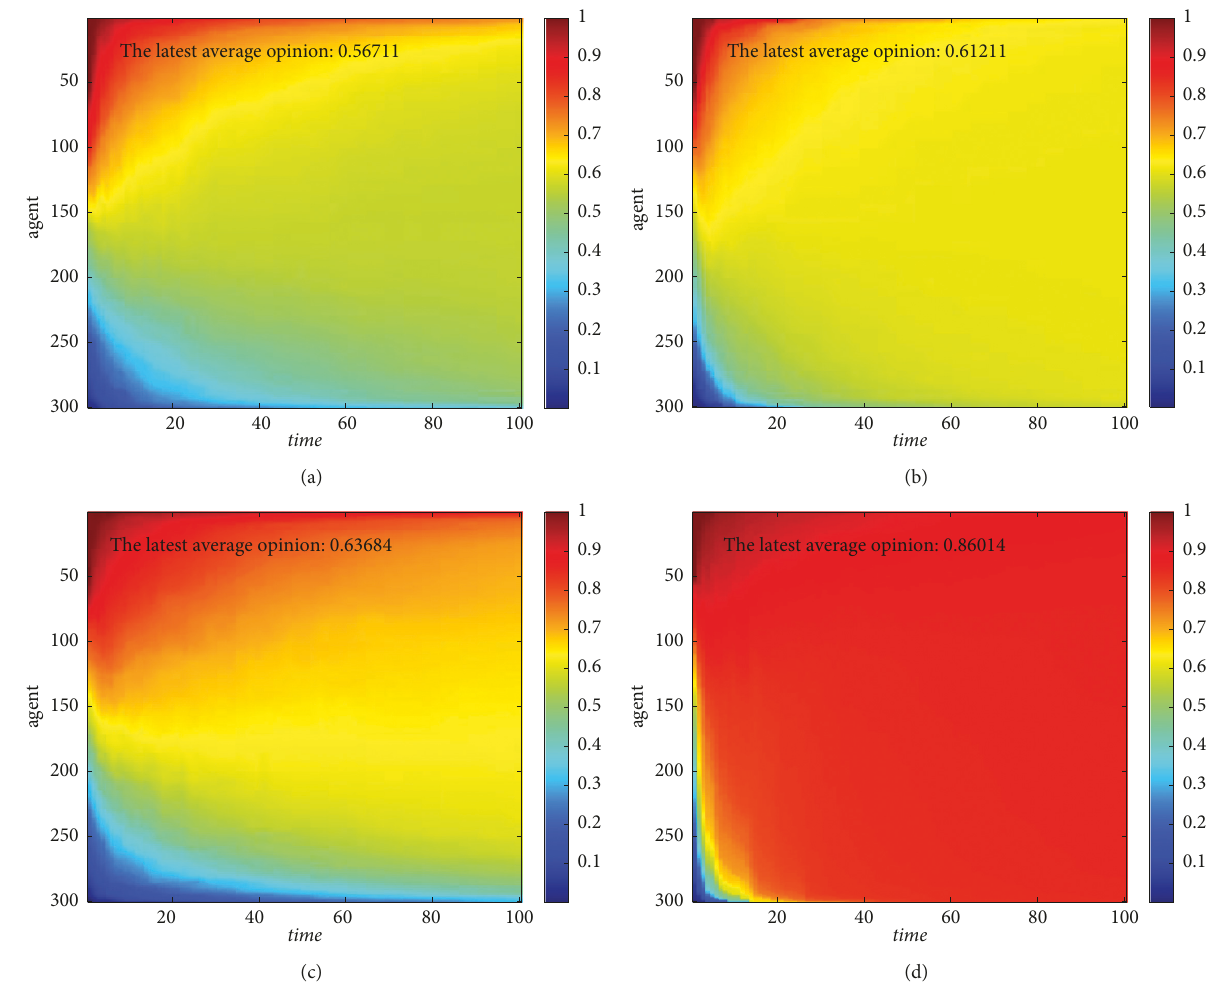
Figure 3: Comparison of guiding effect of key agents in different situation under limit spread, target opinion is 1. (a) Case 1. (b) Case 2. (c) Case 3. (d) Case